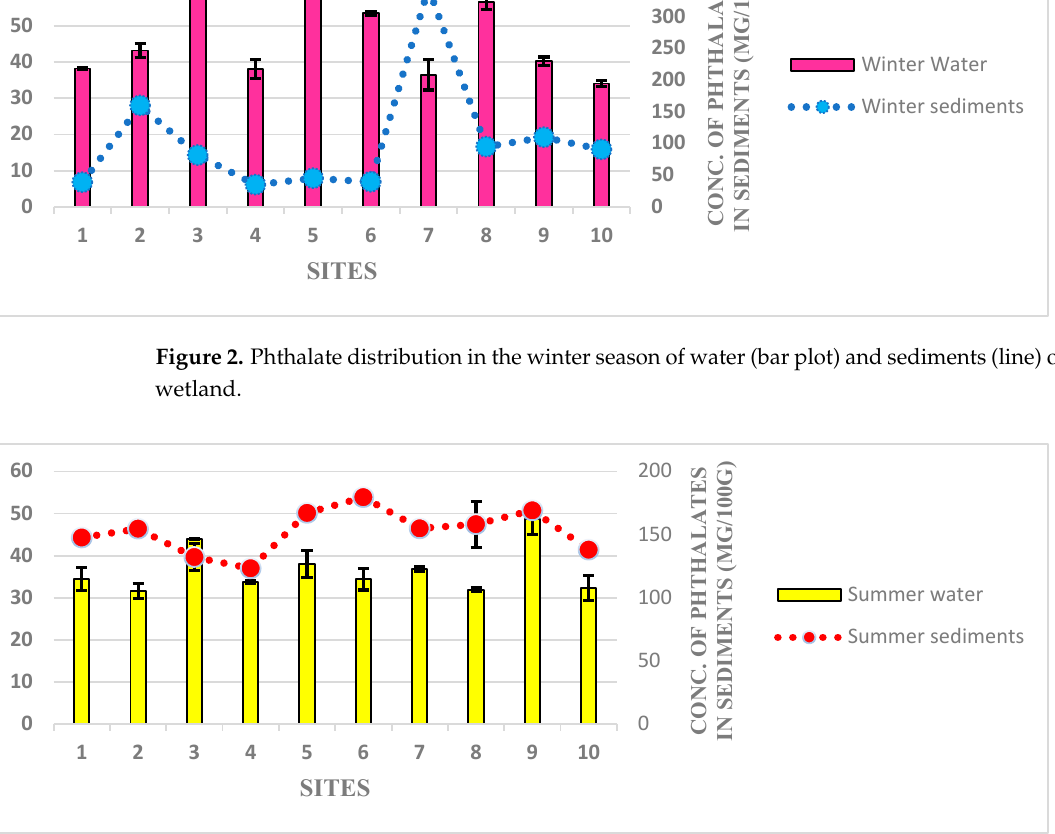
Figure 3. Phthalate distribution in the summer season of water (bar plot) and sediments (line) of Harike wetland.